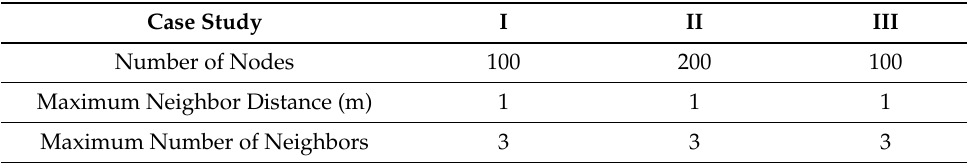
Table A2. Summary of tuning values used for simulations Case